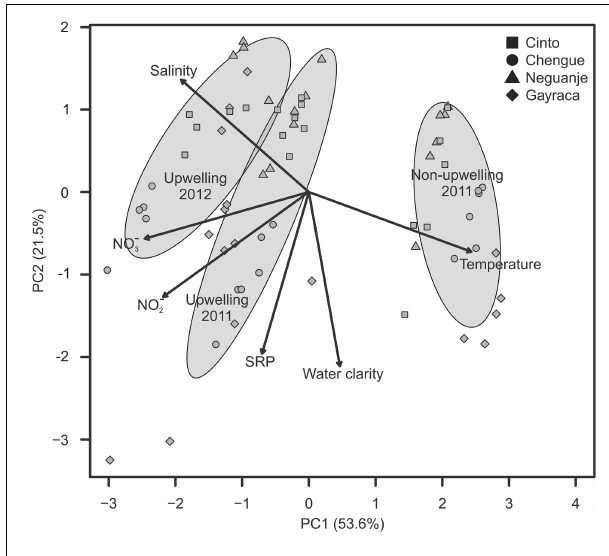
FIGURE 2 | Variation in water parameters shown for the first two components of a principal component analysis. Ellipses indicate groupings (mean group value ± SD) according to the different study periods; arrows show the contribution of each water parameter to the observed variation.